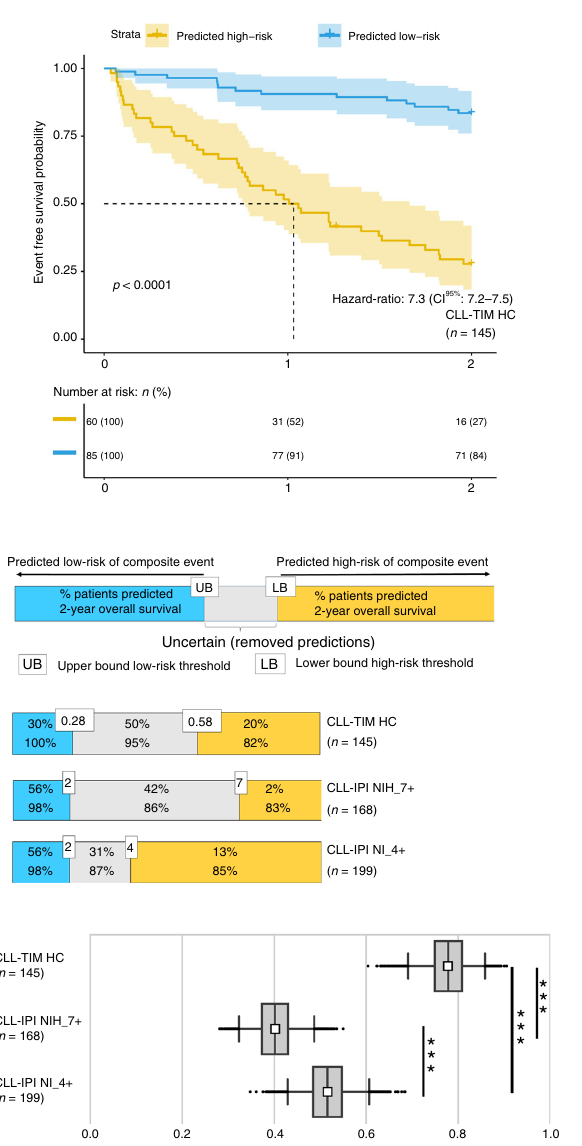
pathology data, blood culture data or diagnosis data; even when set to missing all together – hence, even on predictions for patients with only baseline data, CLL-TIM was still superior to CLL-IPI (Supplementary Fig. 8).